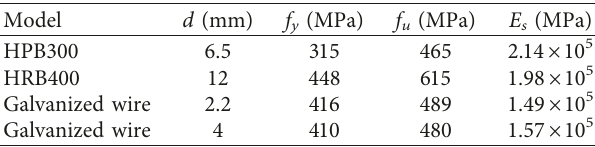
Table 3: Mechanical properties of steel